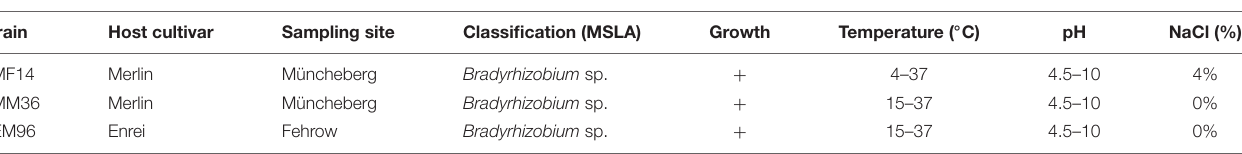
TABLE 2 | Characteristics of Bradyrhizobium